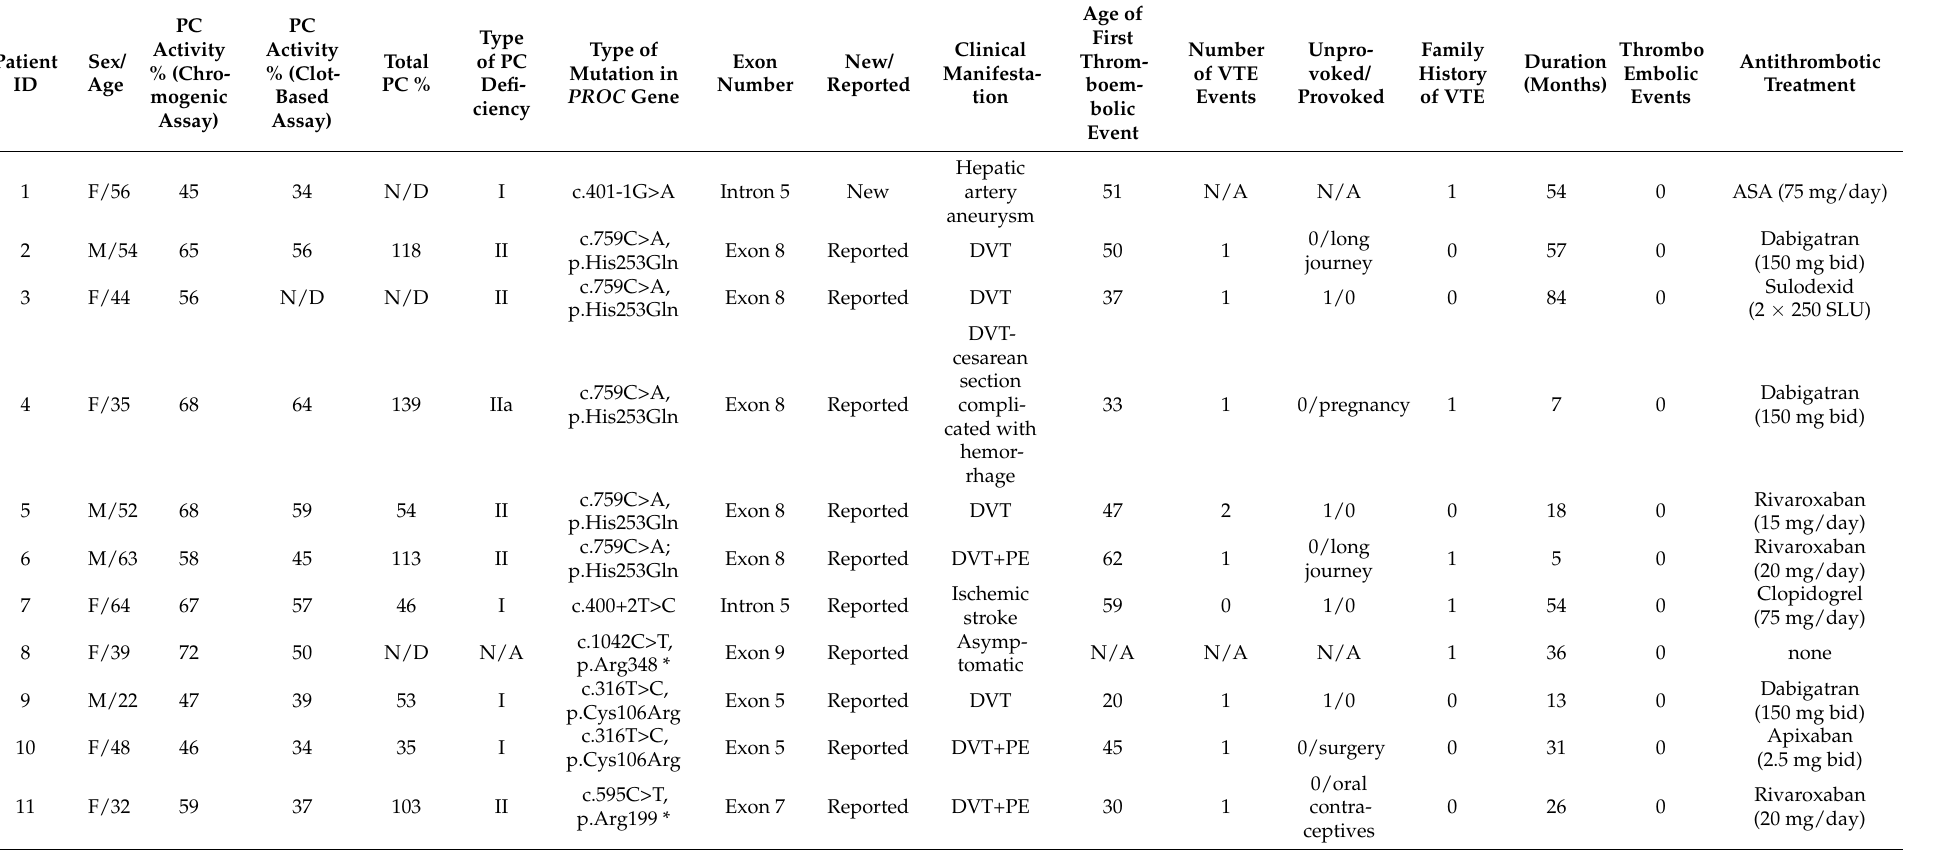
Table 1. Characteristics of patients with protein C (PC) deficiency. Mutations were given coordinates according to the HUGO recommendations for mutation nomenclature (http://www.hgvs.org, accessed on 1 March 2022). Abbreviations: DVT denotes deep vein thrombosis; F, female; M, male; N/A, not applicable;